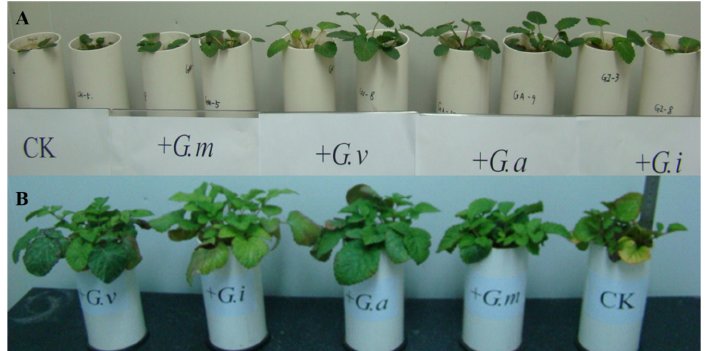
Figure 2. Effect of AMFs inoculation on growth of S. miltiorrhiza seedlings. ( A ): 30 days after sowing;